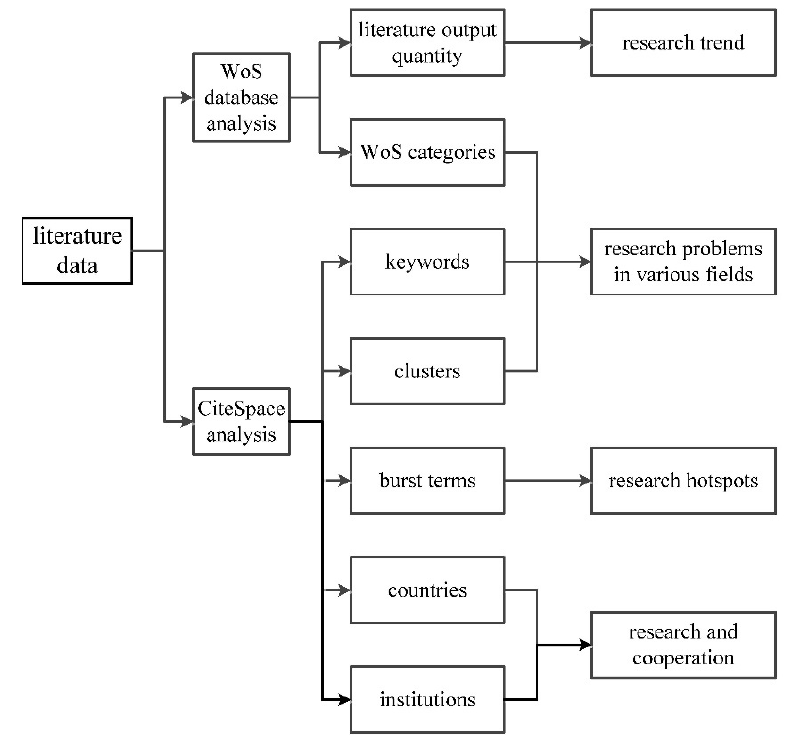
Figure 1. Research method flowchart.